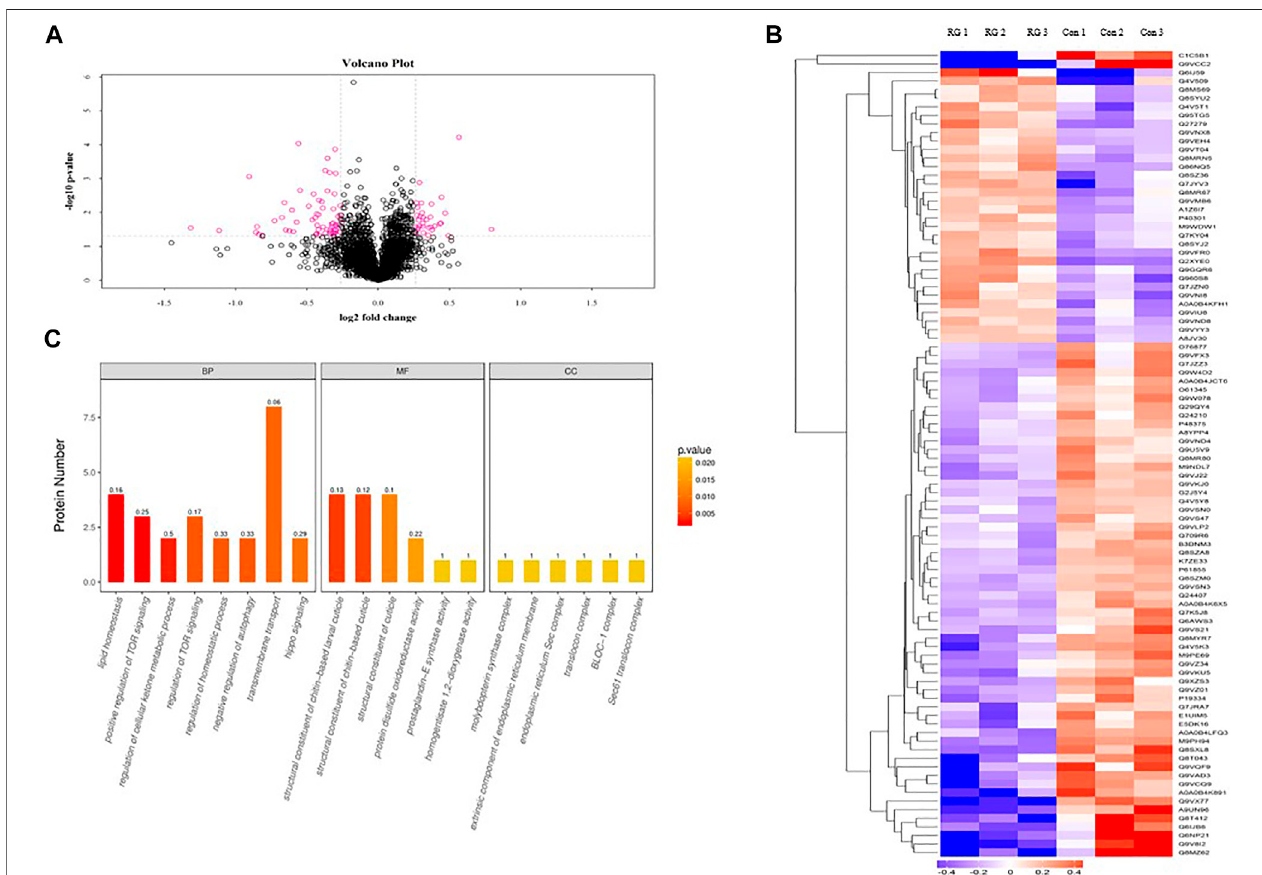
FIGURE 4 | (A) . Volcano plot showed the signi fi cant changes in proteins expression; The pink dots were the differentially expressed proteins in the fi gure (the multiple change was greater than 1.2 times and p value < 0.05). The black dots were the proteins which had not changed. (B) . Clustering heatmaps showed the signi fi cant changes in proteins expression; The red represented signi fi cantly up-regulated proteins. The blue represented signi fi cantly down-regulated proteins. Gray represented no protein quantitative information. (C) . The signi fi cantly changed proteins were analyzed by the Blast2GO program. The abscissa represented the enriched GO terms in the fi gure. Biological Process, BP; Molecular Function, MF; Cellular Component, CC; The ordinate represented the number of differentially expressedproteins.Thecolorgradientrepresentedthesizeofthe p value.Thecloserthecolorwastothered,thesmallerthe p value,andthehigherthesigni fi cancelevel of the enrichment degree of the corresponding GO functional category. The label above the bar chart showed the enrichment factor (Enrichment factor represented the ratio of the number of differentially expressed proteins annotated to a GO function to the number of all identi fi ed proteins annotated to that GO function).; Abbreviation: RG, red ginseng; Con,